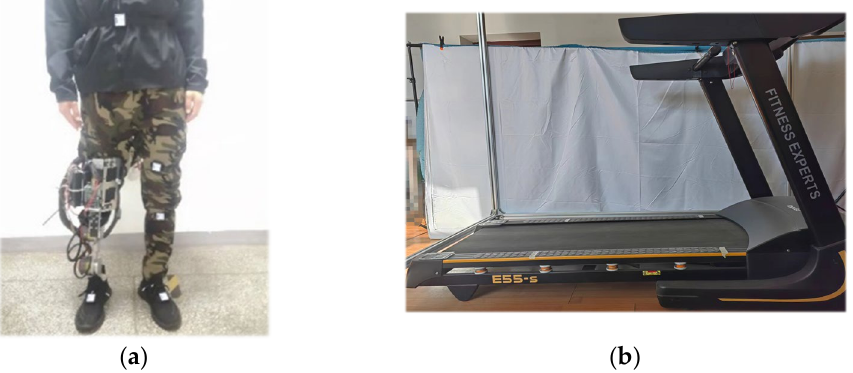
Figure 5. Experimental equipment. ( a ) An able-bodied subject wears intelligent lower-limb prostheses and IMUs. ( b ) The treadmill for level walking.